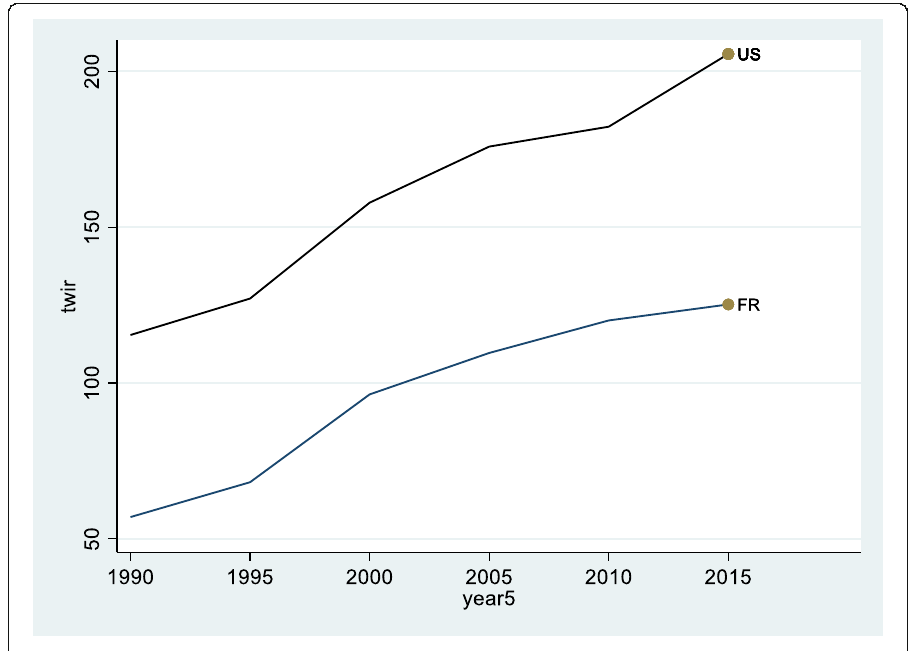
Fig. 2 Top wealth (top 1% of the population ’ s average net wealth) to average income ratio TWIR in the US and France. Source: Authors ’ calculations based on the WID, https://wid.world/, see Alvaredo et al. (2017)